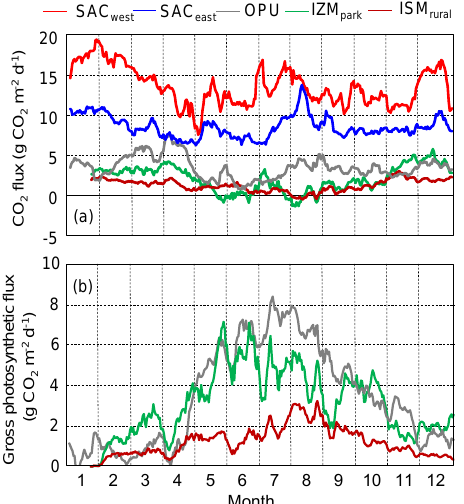
Figure 6. Seasonal variations in the daily mean (a) CO 2 fluxes and (b) the gross photosynthetic flux in 2015, shown as 7-day running means.